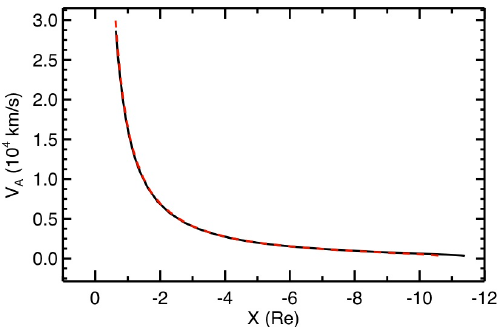
Fig. 6c. (c) shows the Alfv´en speed estimated along the Alfv´en travel path based on the B field shown in Fig. 6a, the number density in Fig. 6b and the line integral algorithm discussed in Sect. 5. The dashed red curve is for the E-1 event, the soliar black curve is for the E-2 event. Table 2. Comparison of Alfv´en travel time and the time delay of the dipolarization onset from the brightening of the onset arc observed in E-1 and E-2. Alfv´en travel time from the TH-D footprint to the neutral sheet in the dipolarization